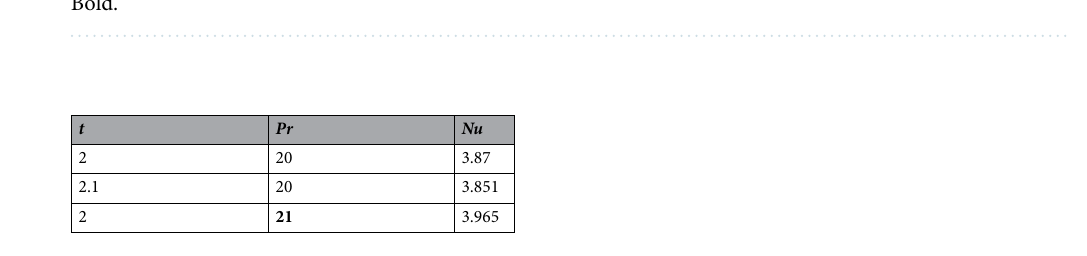
Table 2. Nusselt number of the couple stress Casson fluid at the plate y = 0 for α = 0.2 . Significance values are in Bold.